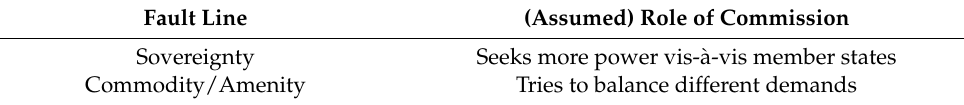
Table 2. Role of the